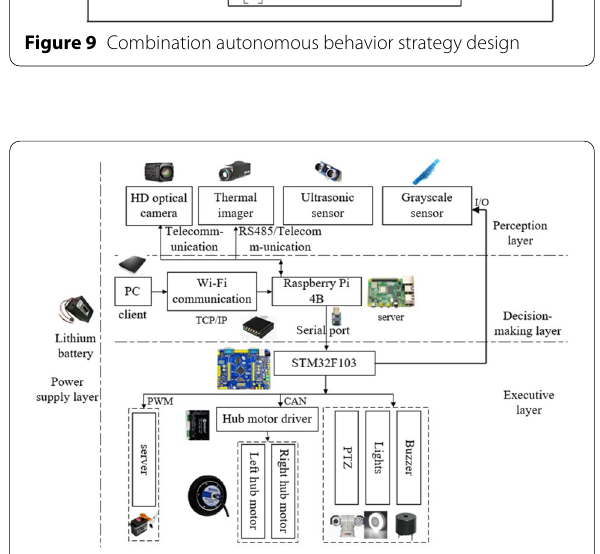
Figure 10 Structure of robot control system